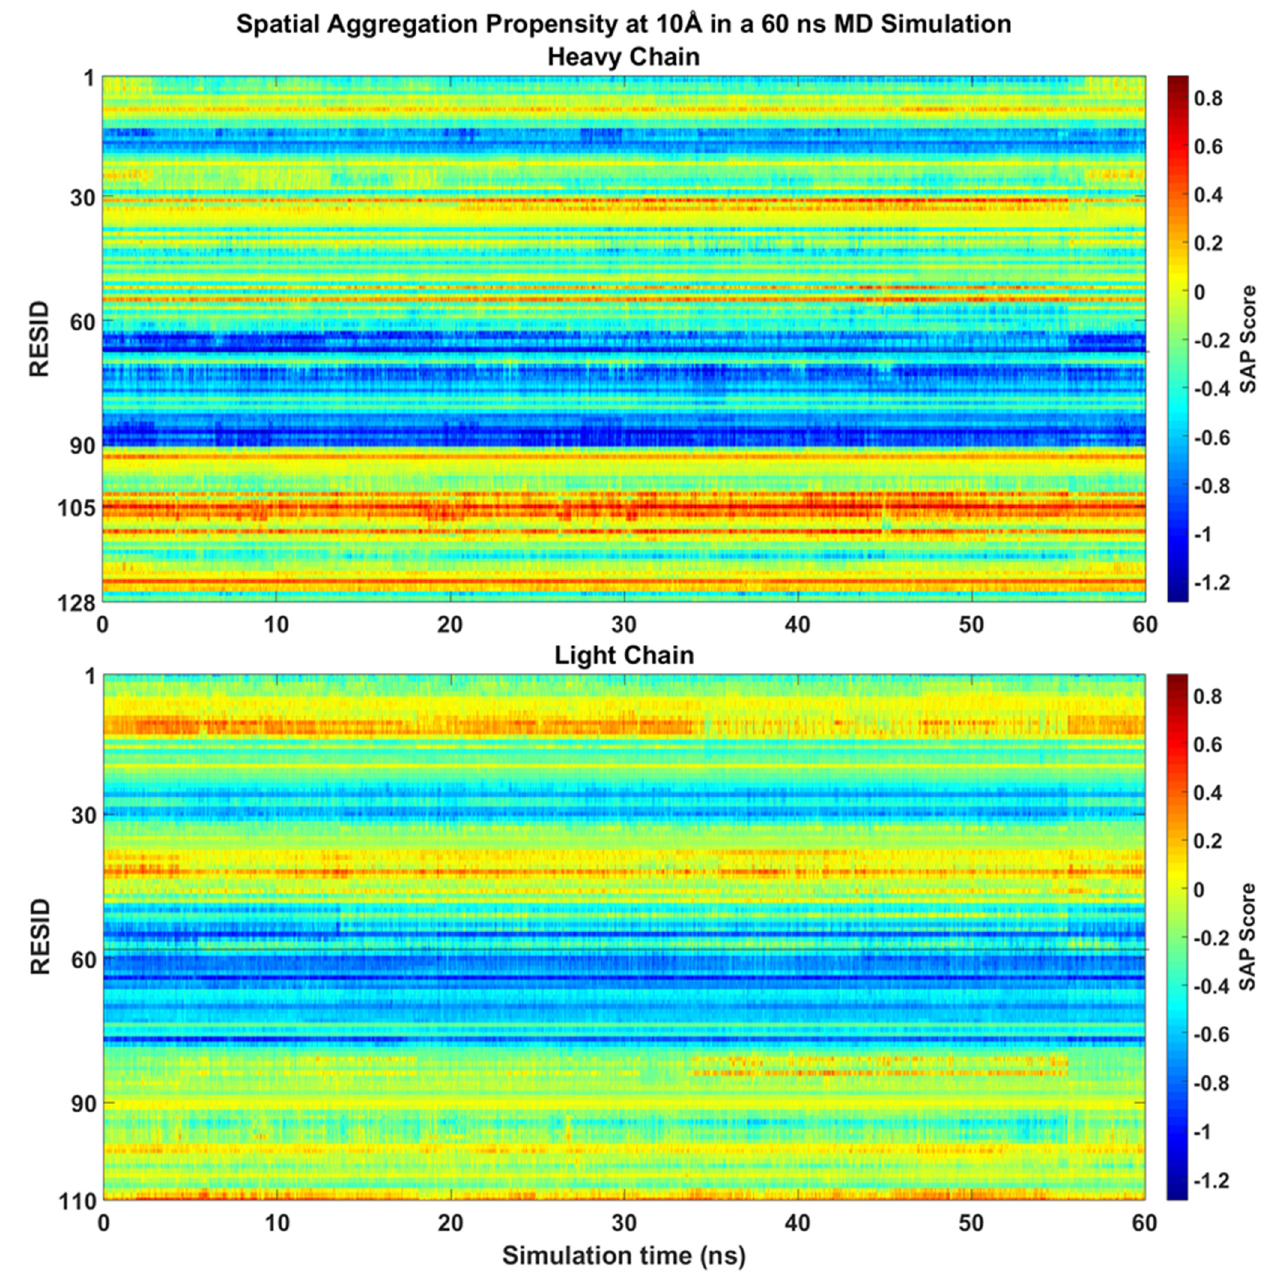
Figure 3. SAP values calculated at R = 10 Å over a 60 ns all-atom MD simulation. The SAP score for most residues within the Fv fragment remained stable the simulation with LEU105 on the heavy chain identified as the most solvent-accessible hydrophobic patch on the Fv fragment.